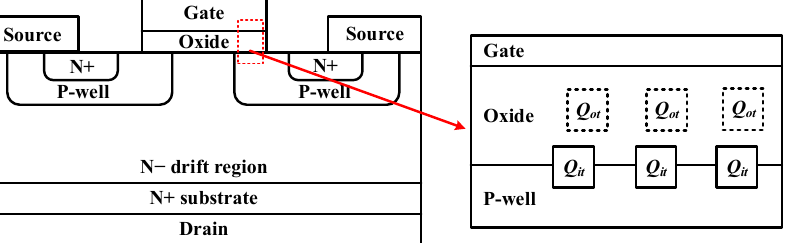
Figure 1. Structure of the MOSFET and the gate oxide layer.